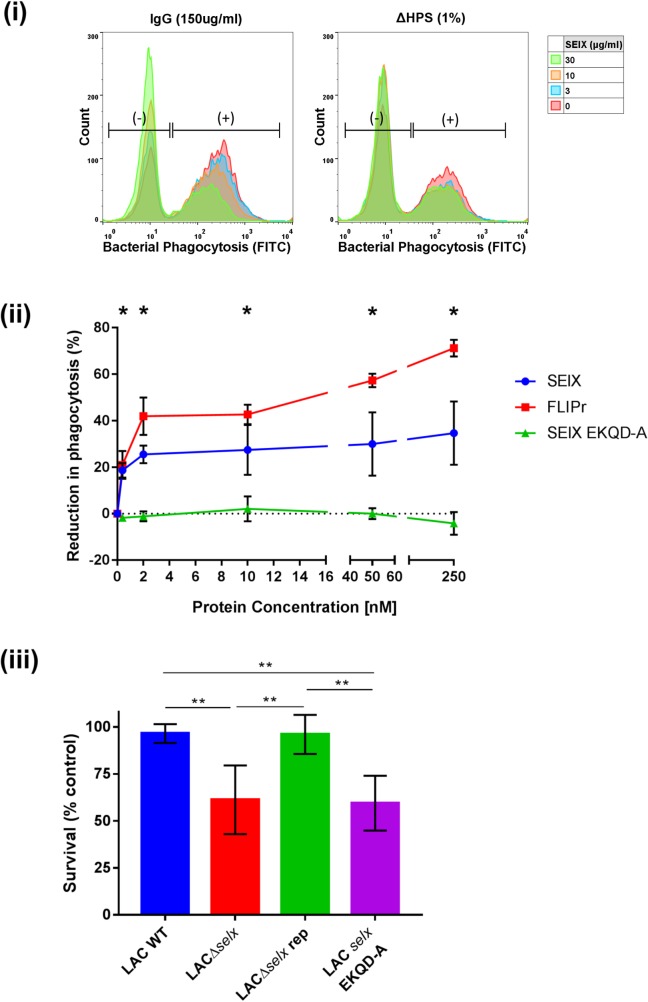
SElX inhibits IgG-mediated neutrophil phagocytosis and reduces killing by human neutrophils.(i) Phagocytosis of fluorescent-labelled S. aureus opsonized with 150 μg/ml of purified human IgG or 1% (v/v) complement-inactivated human pooled serum (ΔHPS), in the presence of SElX at various concentrations. Gates indicate the populations of neutrophils that have phagocytosed bacteria or not (+/-). (ii) Inhibition by recombinant SElX protein was compared to the IgG-mediated phagocytosis inhibitor FLIPr and the neutrophil-binding deficient mutant SElX EKQD-A. Phagocytosis was calculated as the percentage of cells with fluorescent bacteria and expressed relative to buffer-treated cells with 75 μg/ml human IgG. Results shown are the means of three different human donors (error bars SE of mean). Results between SElX wild-type and SElX EKQD-A protein were tested by two-way ANOVA and found to be significantly different, *indicates at which concentration a significant difference in phagocytosis was observed. (iii) S. aureus USA300 wild-type, selx deletion and site-directed mutants were incubated with isolated human neutrophils for 60 min. Following incubation neutrophils were lysed with Triton-X 100 and surviving bacteria plated and enumerated. Killing was calculated as the difference between the no neutrophil control and the surviving CFU. Data shown are the mean % surviving bacteria incubated with cells from 5 donors ± SD. CFU data were tested by students t-test (unpaired, two-tailed) with Welches correction, (* indicates a p value < 0.05, ** indicates a p value < 0.01).